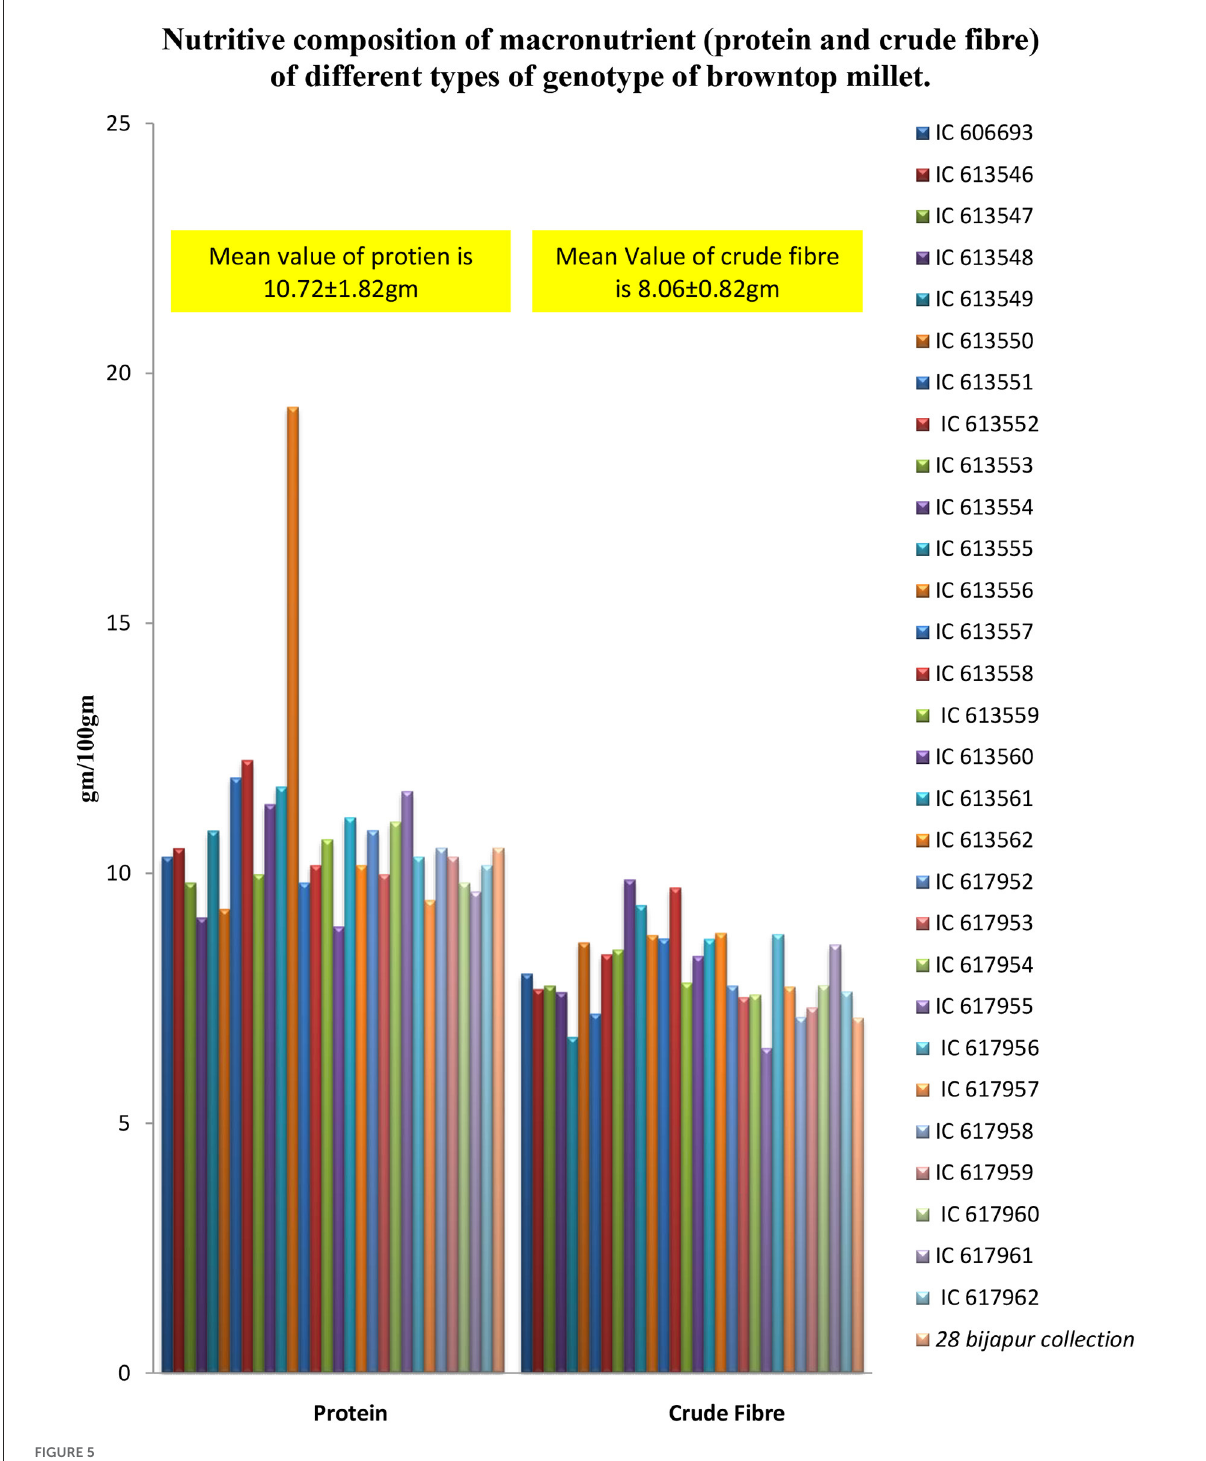
FIGURE5 Nutritive composition of macronutrient (protein and crude fiber) of different types of genotype of browntop millet. Source: Niharika et al. (2020).